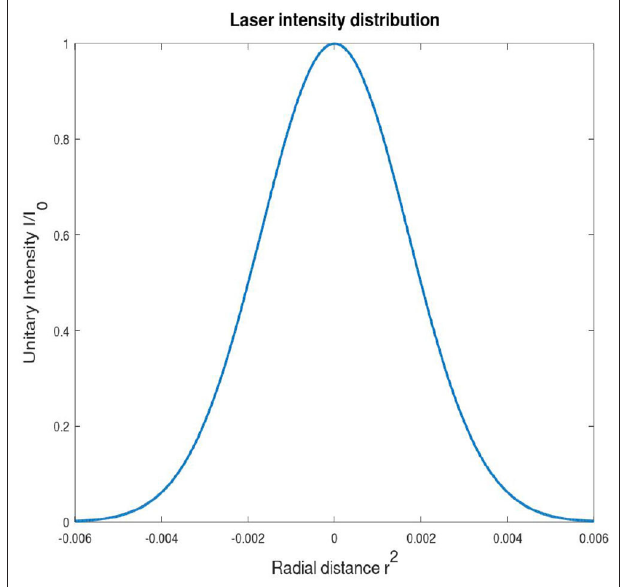
FIGURE 1 | The intensity distribution of a laser when TEM 00 and z